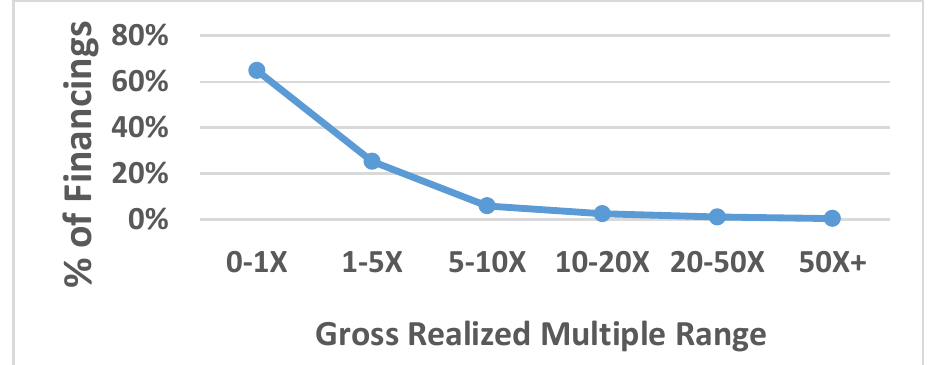
Figure 1. Typical distribution of venture capital returns. The Association of University Technology Managers (AUTM) is an organization that collects and reports technology transfer data from universities and other institutions. An AUTM royalty income graph illustrates a similarly skewed distribution of venture capital returns (see Figure 2). A few institutions receive a significant income from their IP portfolio, but the vast majority do not break even. If one plots the AUTM income data on a log– log scale, the data approximate a straight line, suggesting a power-law distribution (see Figure